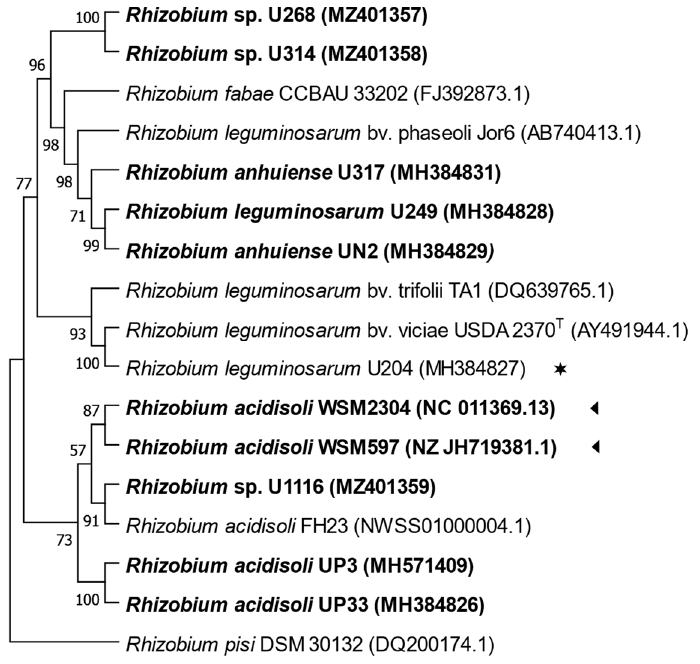
Figure 2. Maximum likelihood tree inferred from partial sequences alignments of ITS region (963 bp). All strains isolated from Uruguayan soils are indicated in bold letters. ( ◄ ), native strains whose genome sequences are available from Genebank; ( ), the commercial inoculant. Bootstrap values of 50 or more (based on 1000 replicates) are indicated.